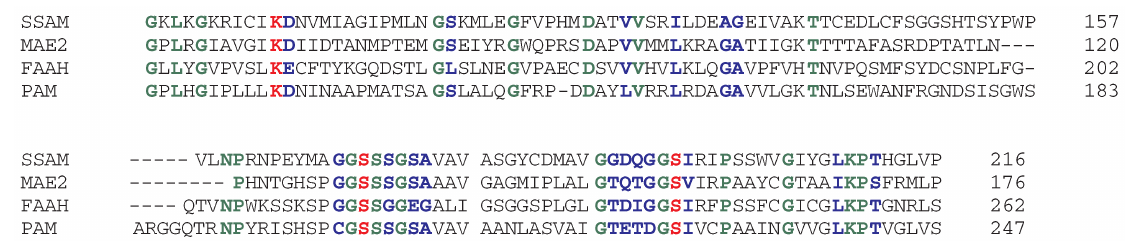
Figure 6. Sequence alignment of the conserved stretch. The 130 amino acids, including the “amidase signature sequence” of Sulfolobus solfataricus amidase (SSAM) (GB AF290611), malonyl amidase E2 (MAE2) from Bradyrhizobium japonicum (PDB 1GR8), fatty acid amide hydrolase (FAAH) from Rattus norvegicus (PDB 1MT5) and peptidyl amidase (PAM) from Stenotrophomonas maltophila (PDB 1M22). Invari- ant residues are reported in green whereas conservative residues are in blue. The catalytic triad (K, S, S) is indicated in